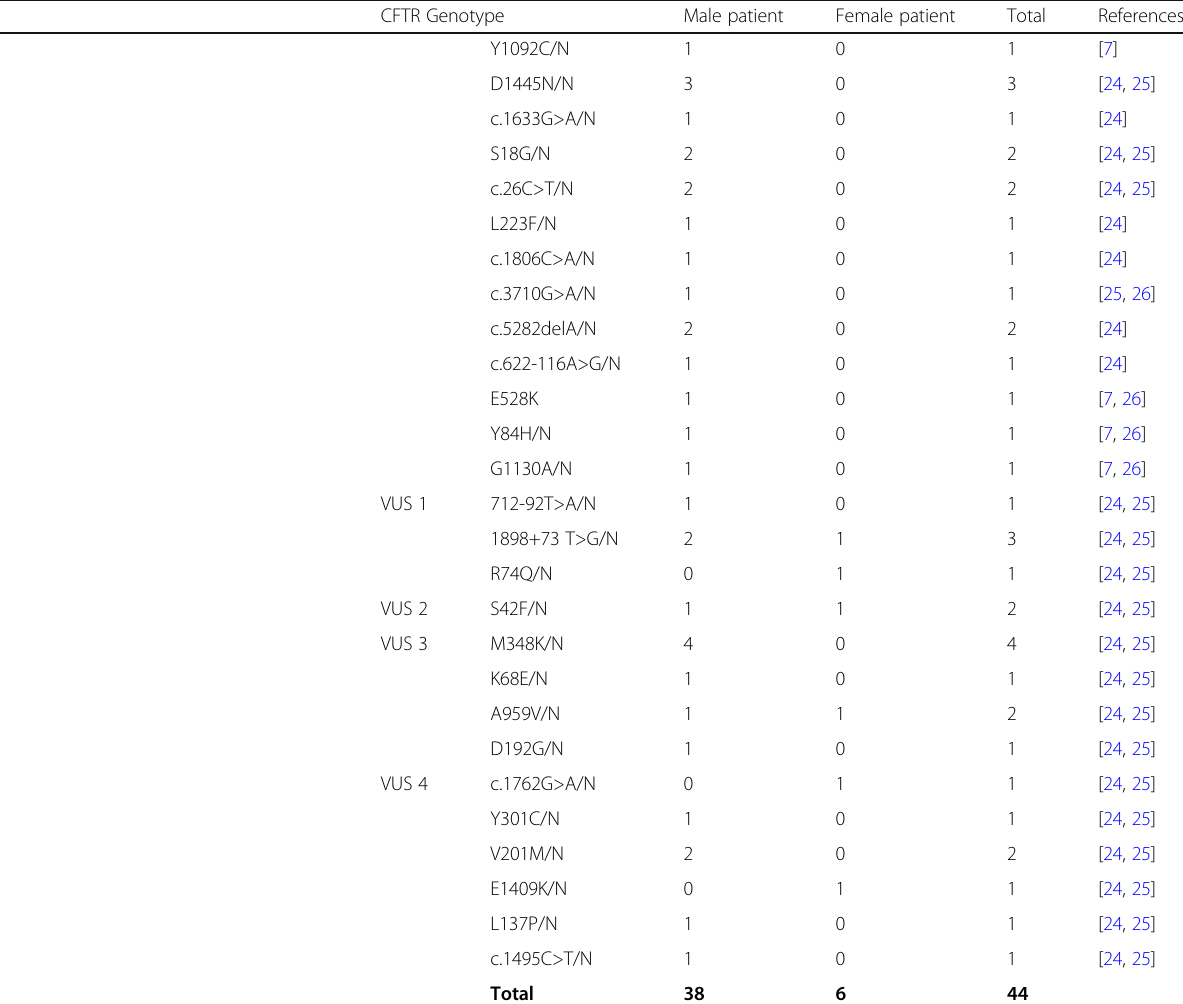
Table 1 CFTR Genotype of the tested eastern Sicilian infertile population (Continued) CFTR